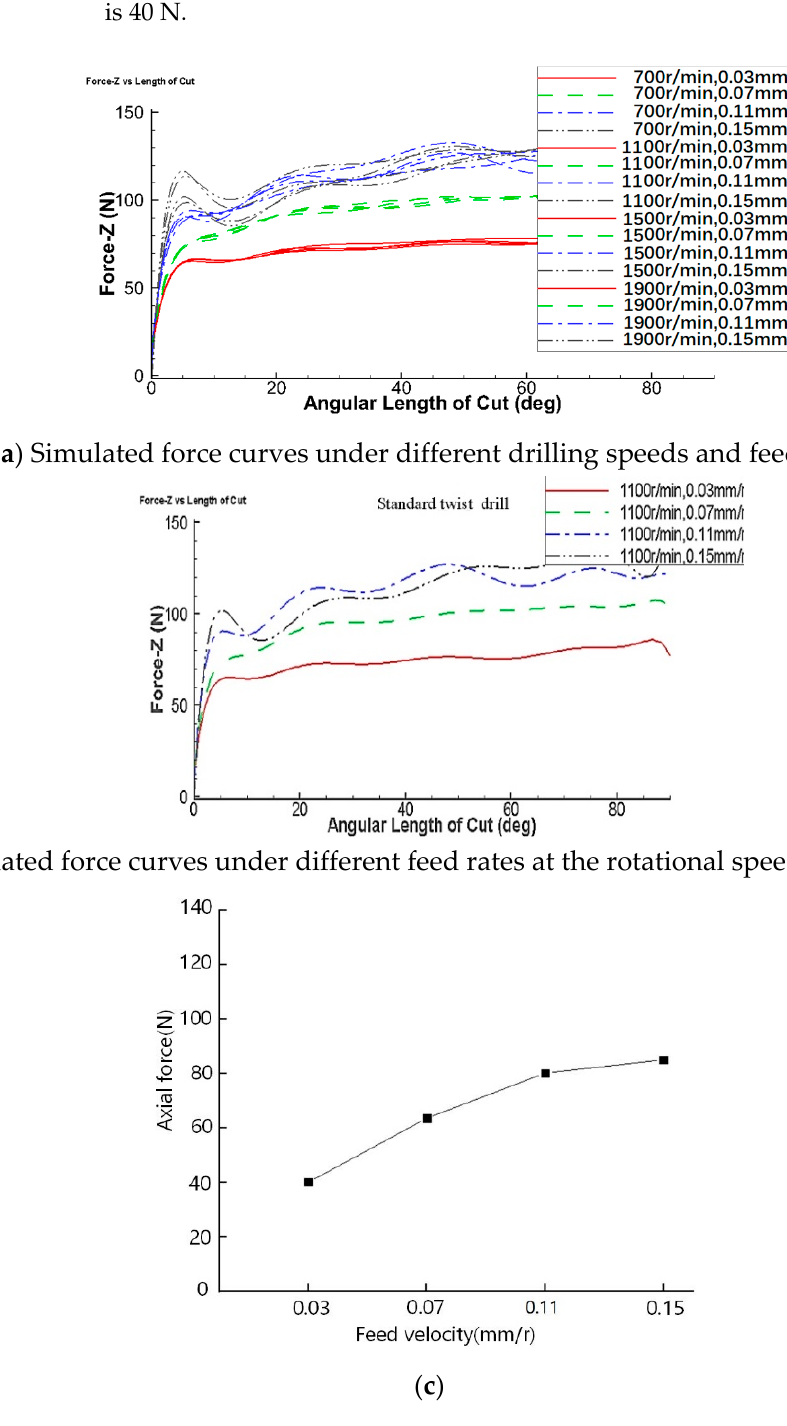
Figure 3. Variation of the drilling force with drilling parameters.